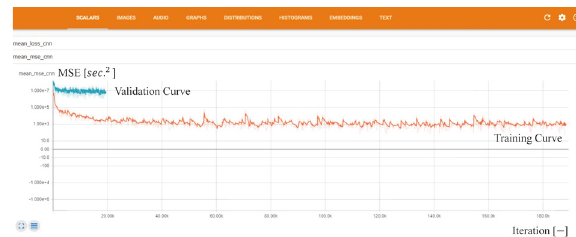
Figure 10: Prediction of total waiting time with TensorFlow